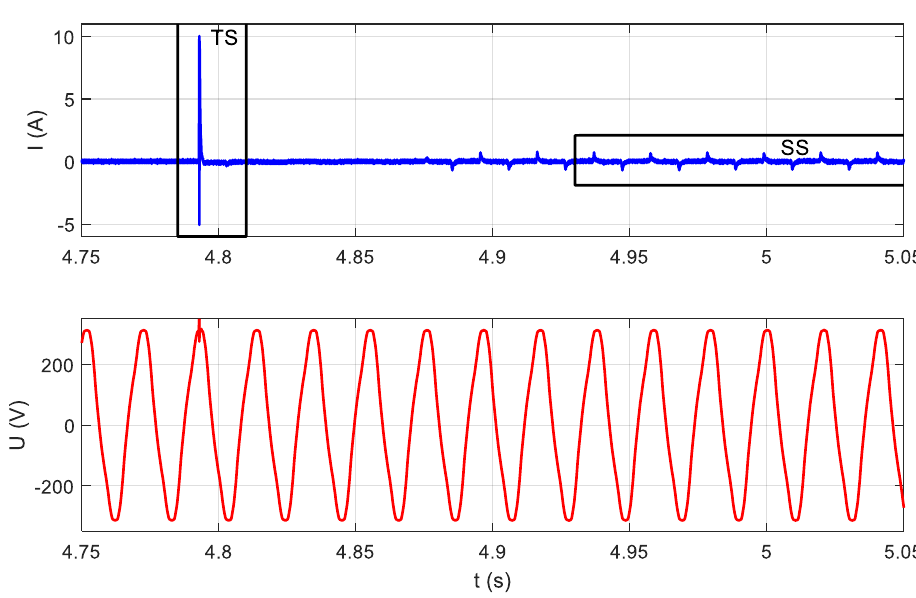
Figure 6. Moment 1, switching on the LED bulb ( A ).